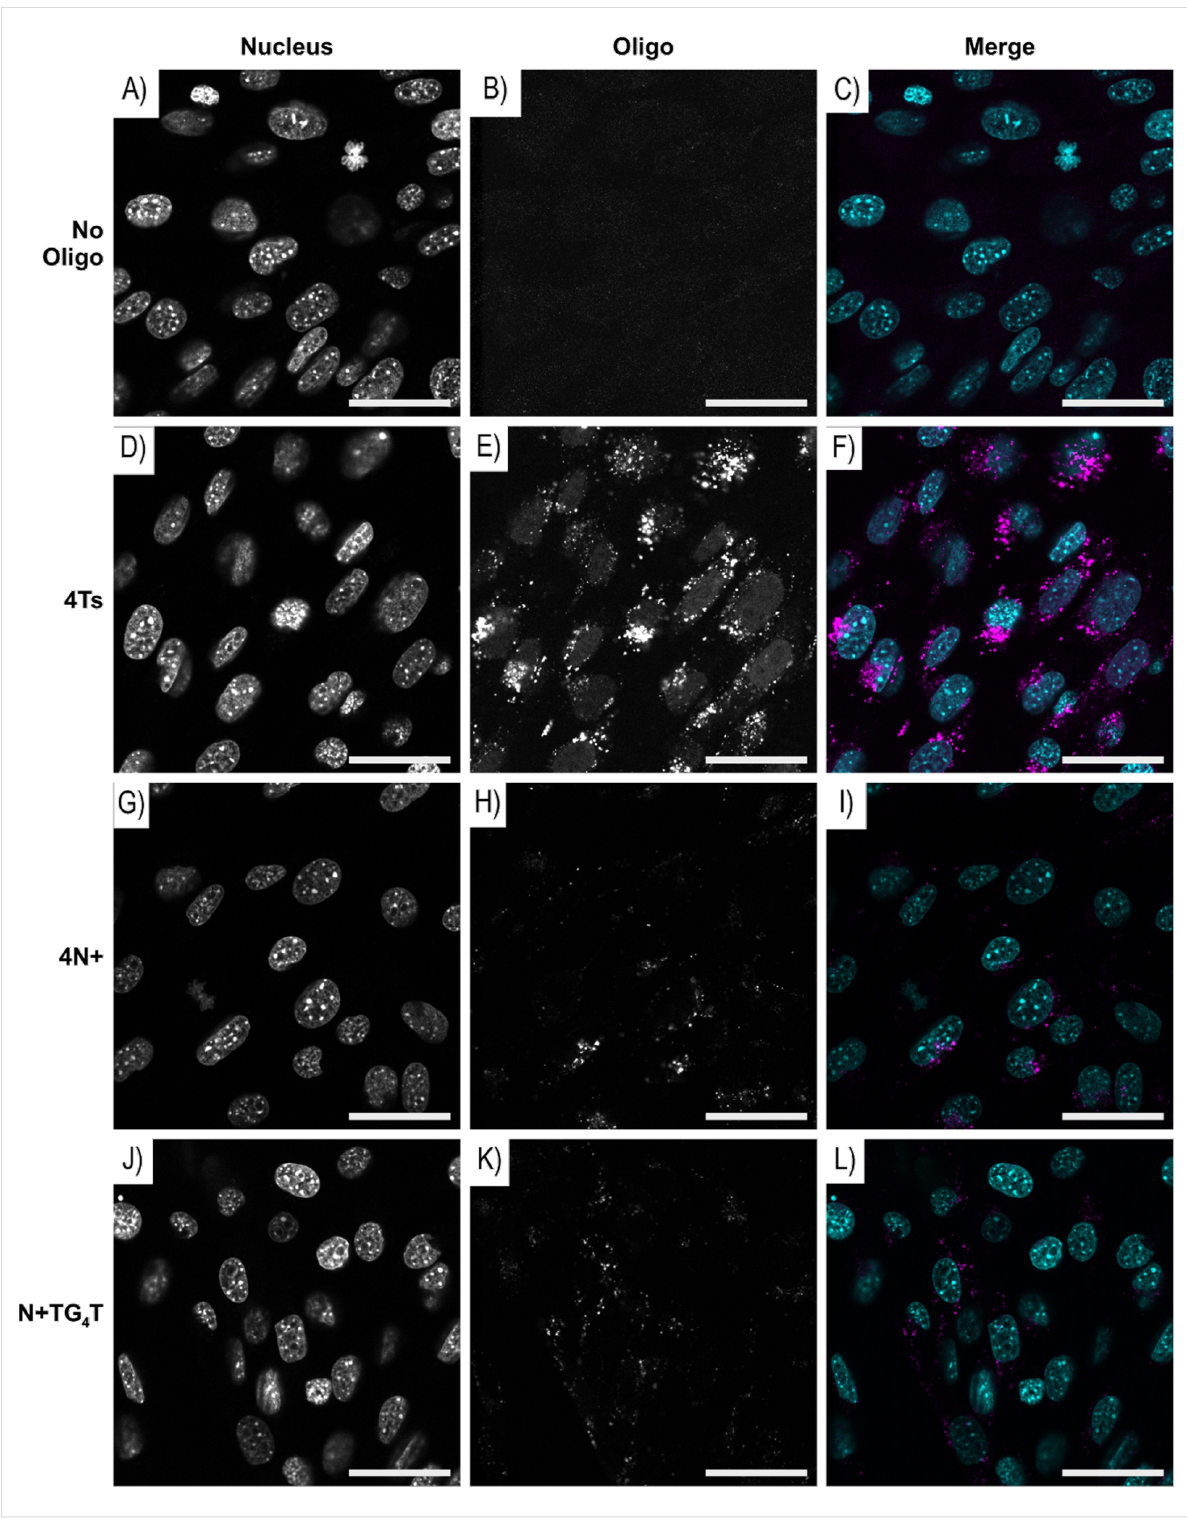
Figure 3: Representative images of mouse NIH 3T3 fibroblasts incubated with either (A–C) no oligo or 20 µM of (D–F) 4Ts, (G–I) 4N+, and (J–L) N+TG 4 T FAM labelled ONs. Asynchronously growing NIH3T3 cells were incubated for 12 hours with 20 µM of the stated FAM-labelled ONs or with- out ON, then fixed with 4% paraformaldehyde before staining with Hoechst 3342 to identify nuclear DNA. The images were collected with a Leica SP5 DM6000B scanning confocal microscope. Individual panels, nucleus/Hoechst 3342 and oligo/FAM are shown for each section, along with merge where pseudo-coloured panels are overlaid, nucleus (blue) and oligo (magenta). Scale bar: 40 μ